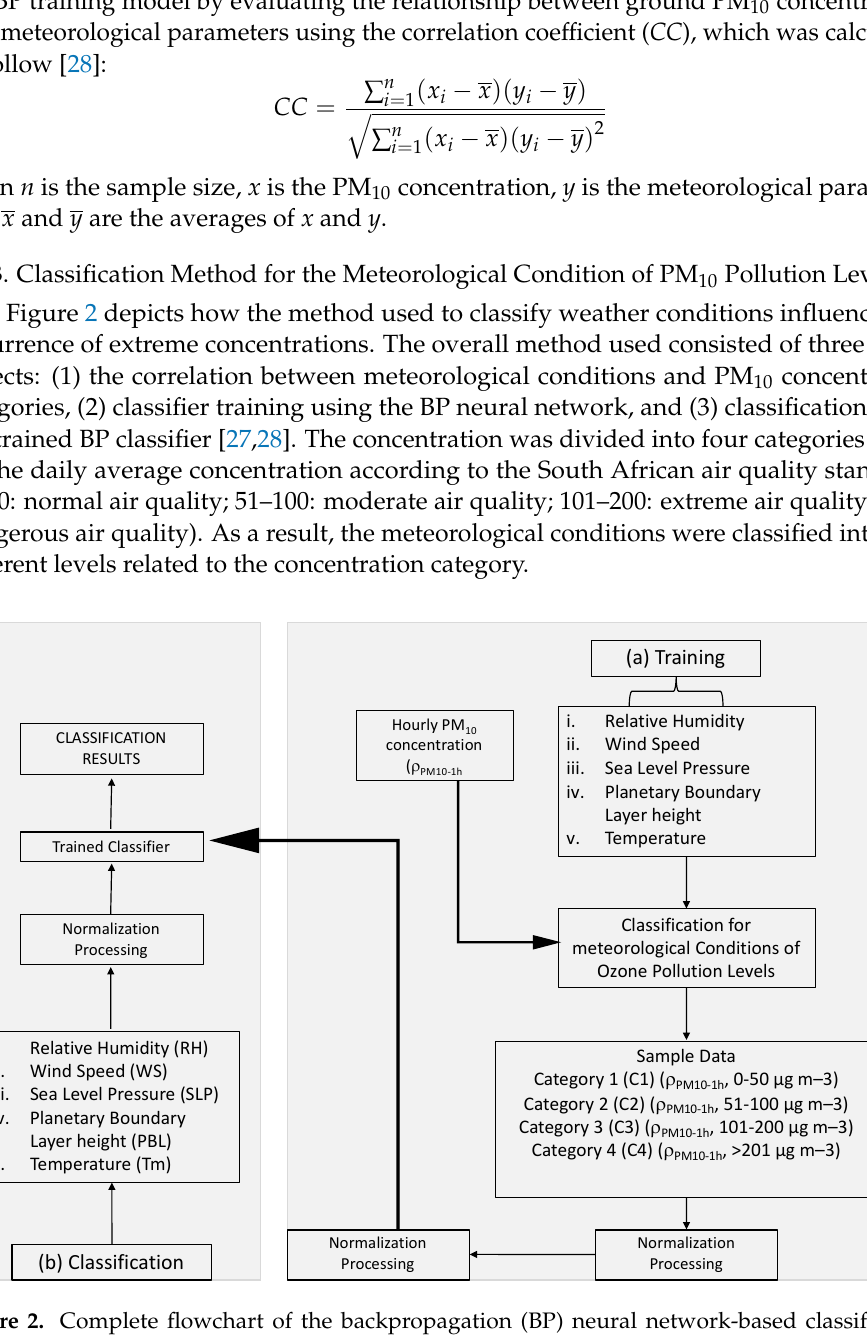
Figure 2. Complete flowchart of the backpropagation (BP) neural network-based classification method for meteorological conditions affecting PM 10 pollution categories.